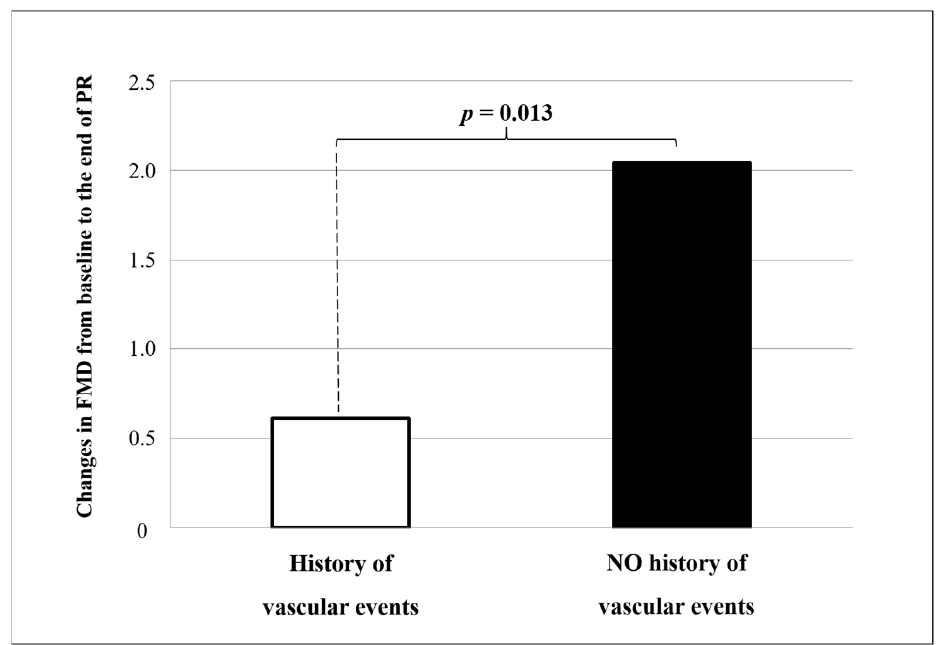
Figure 1. Changes in flow-mediated dilation (FMD) from baseline to the end of pulmonary rehabilitation according to history of vascular events. The p -value is for non-parametric comparison.